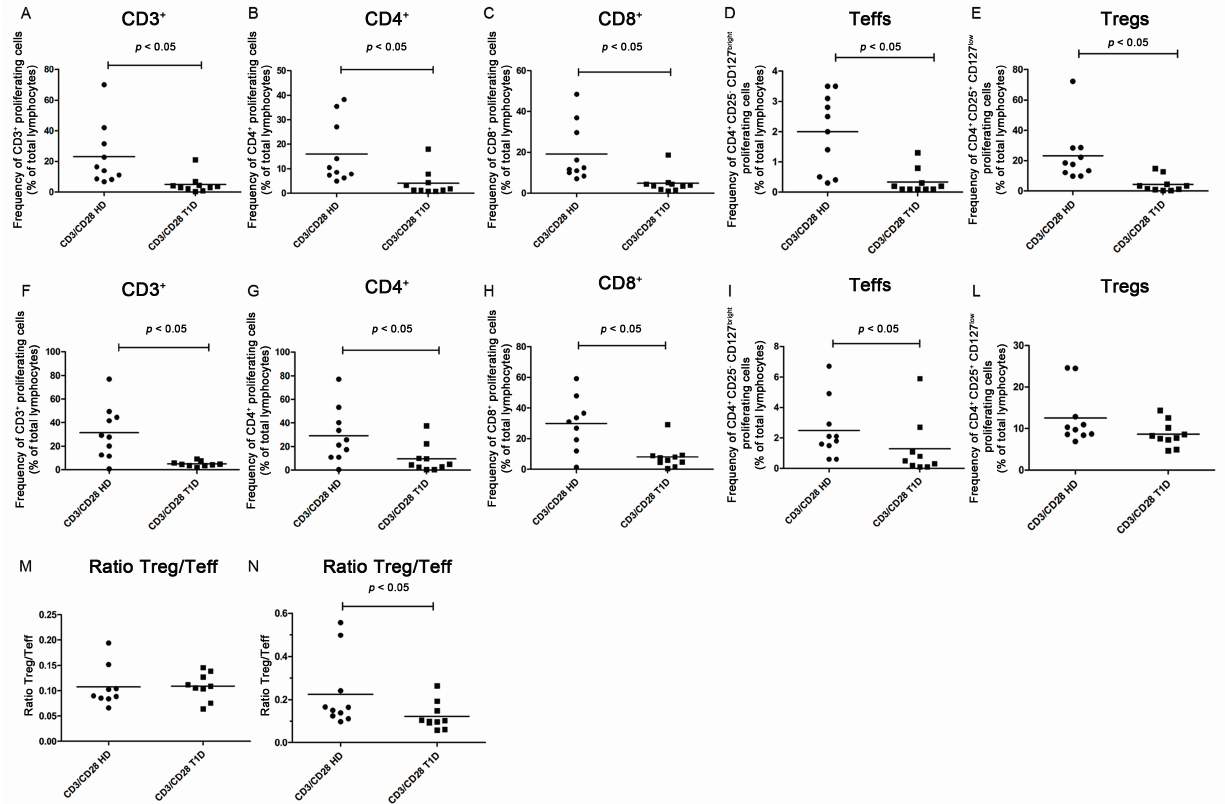
Figure 2. T cell, Teff, Treg proliferative responses and the Treg/Teff ratio after CD3/CD28 stimulation in healthy controls and in T1D patients. 5-chloromethylfluorescein diacetate (CMFDA)-labeled PBMC from healthy controls and from T1D patients were stimulated with CD3/CD28-coated beads for four days (upper panels, A–E and M) and six days (bottom panels, F–L and N). Graphs show the frequency of CD3 + , CD4 + , CD8 + , Teff, Treg proliferating cells after 4 ( A – E ) and 6 days ( F – I , L ) and Treg/Teff ratio after four days ( M ) and six days ( N ) of culture in healthy controls and T1D patients. Proliferation was calculated as percentages of CMFDA-low cells within the total subset after CD3/CD28 stimulation over the percentages of CMFDA-low in RPMI unstimulated cultures. In all graphs, horizontal lines represent the mean frequency and each symbol represents an individual: black circle represents the normal and square dot the